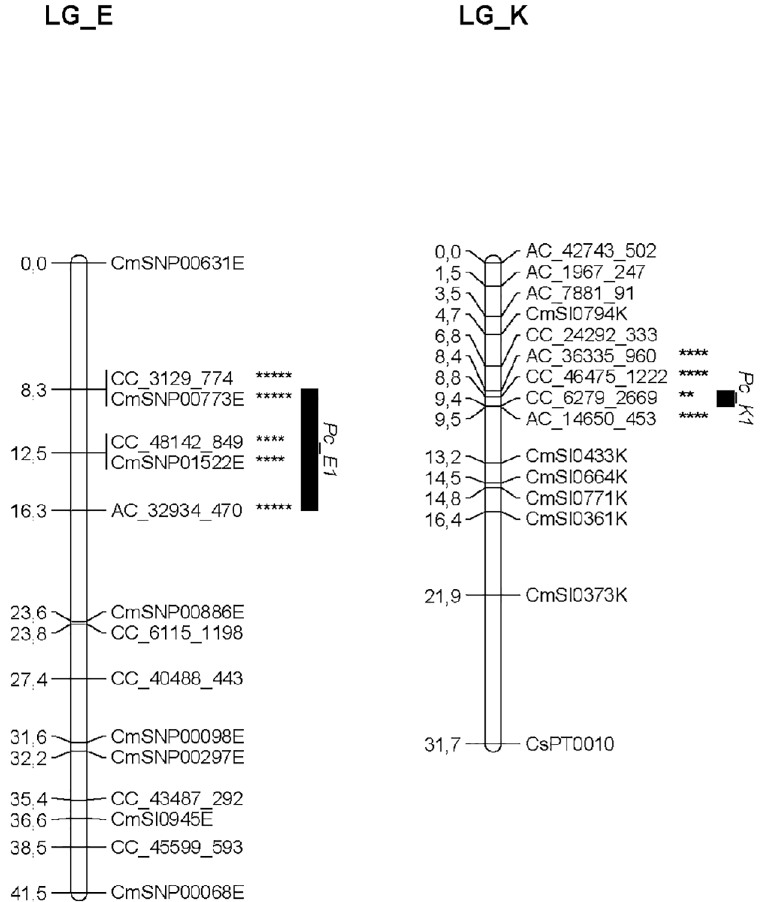
Fig 2. QTLs detected on the linkage groups of the C . sativa x C . crenata consensus genetic map by multiple QTL mapping (MQM) for P . cinnamomi resistance. QTLs are represented by black boxes. Asterisks represents the significance levels obtained by Kruskal-Wallis test: ** = 0.05, **** = 0.005 and ***** = 0.001.